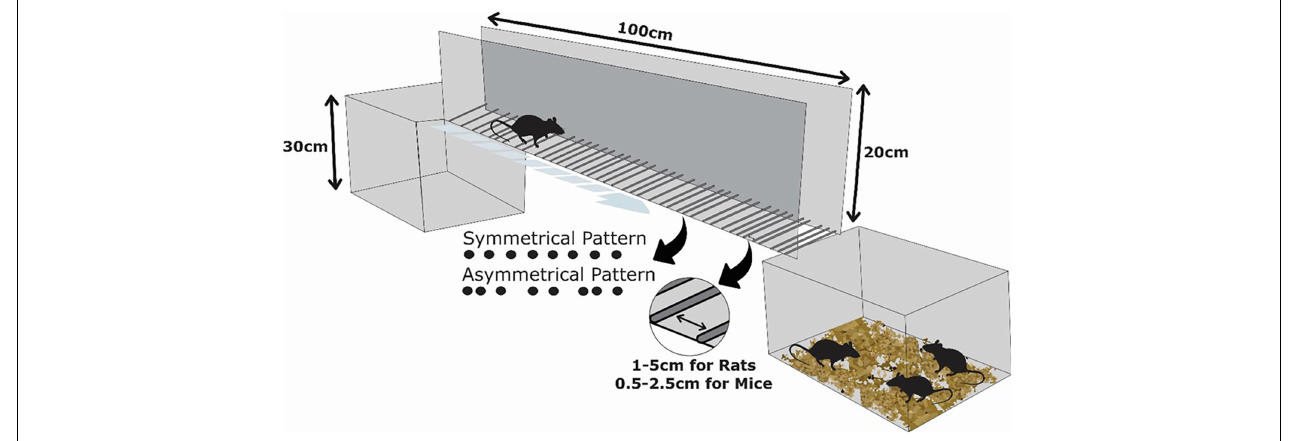
FIGURE 1 | Schematic illustration of the ladder rung walking test apparatus. Note that the rungs could be inserted in symmetrical or asymmetrical patterns. The between-rung space could be varied from 1 to 5 cm for rats and from 0.5 to 2.5 cm for mice. The animal starts the trial from the empty box and is expected to walk to achieve the home cage.